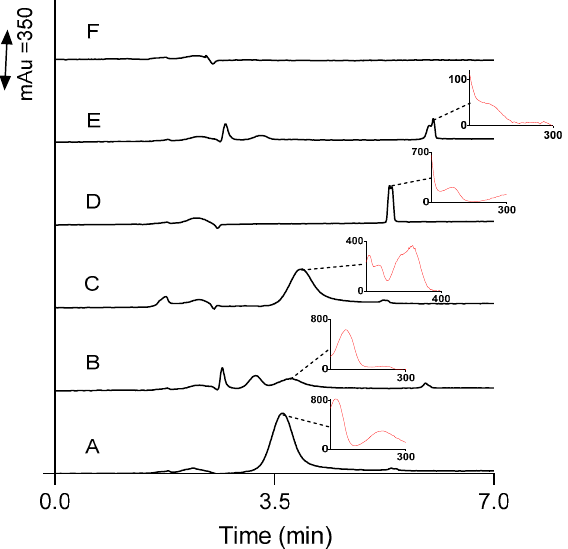
Figure 4. Chromatograms and spectra of organic acids: gallic (pK a = 4.2, trace A), benzoic (pK a = 4.1, trace B), chlorogenic (pK a = 3.6, trace C), salicylic (pK a = 2.9, trace D), phthalic (pK a = 5.4, trace E) and sulfate (trace F) using the optimized conditions for nitrite and nitrate determination by IT-SPME- IE-CapLC-DAD. Phthalic and salicylic acids were assayed at 1 mg/L, chlorogenic, benzoic and gallic acids at 3.5, 0.5 and 1.7 mg/L,